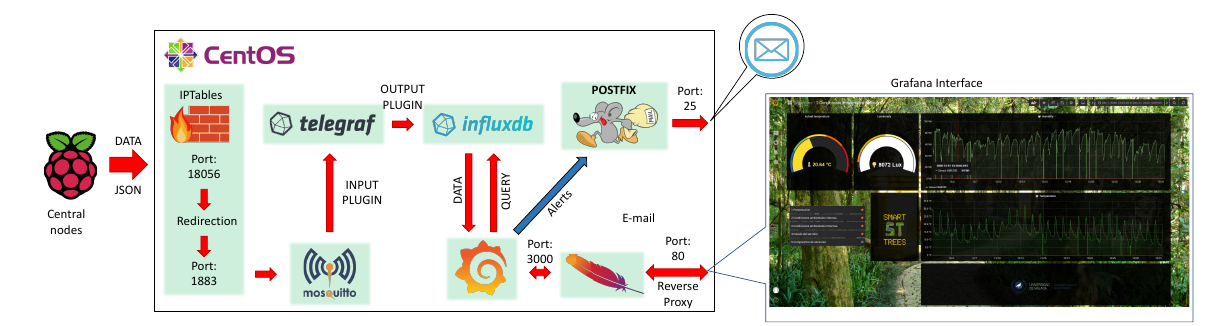
Figure 15. Insight of server software and datapath from reception to graphical